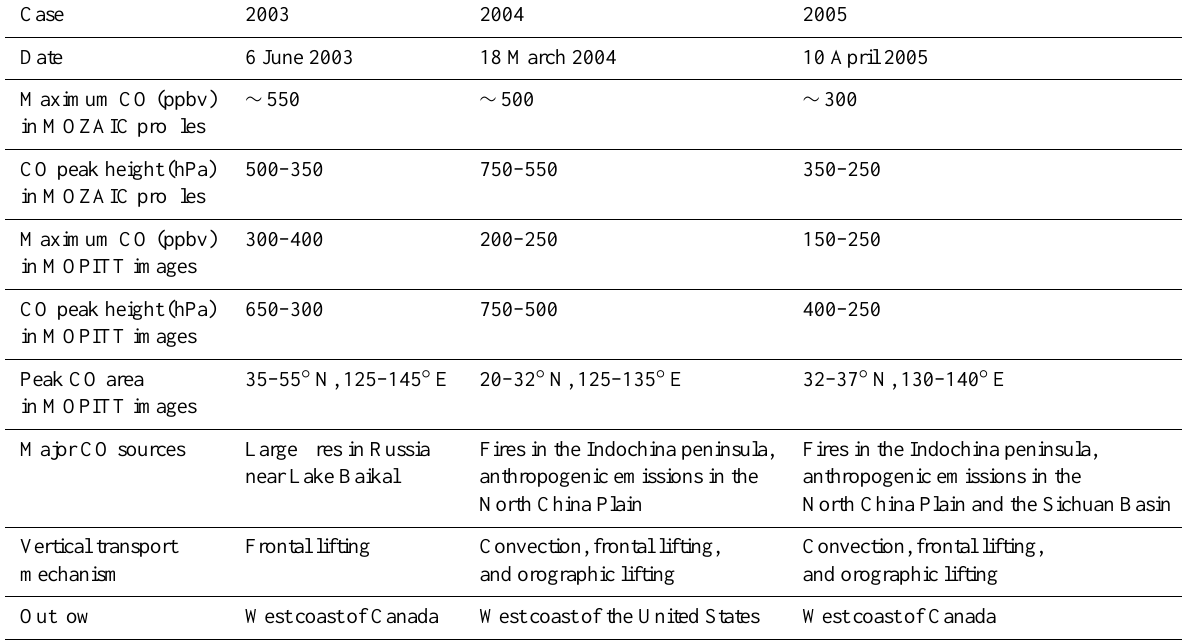
Table 1. Characterization of the three